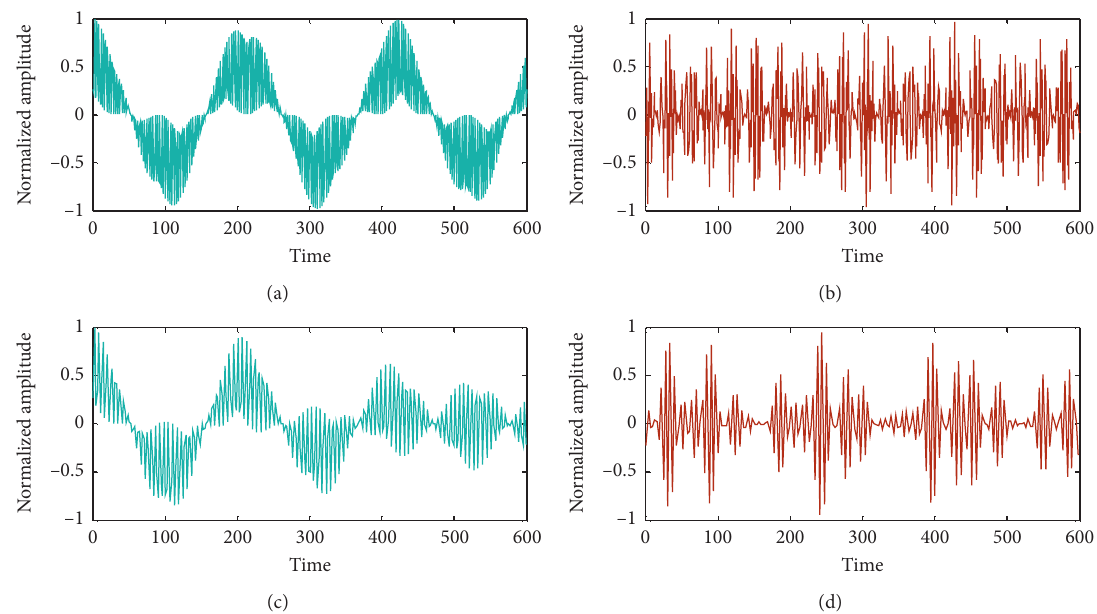
Figure 7: Waveform comparison before and after music segment separation. (a) Original accompaniment waveform. (b) Original singing waveform. (c) Accompaniment waveform after separation. (d) Singing waveform after separation.